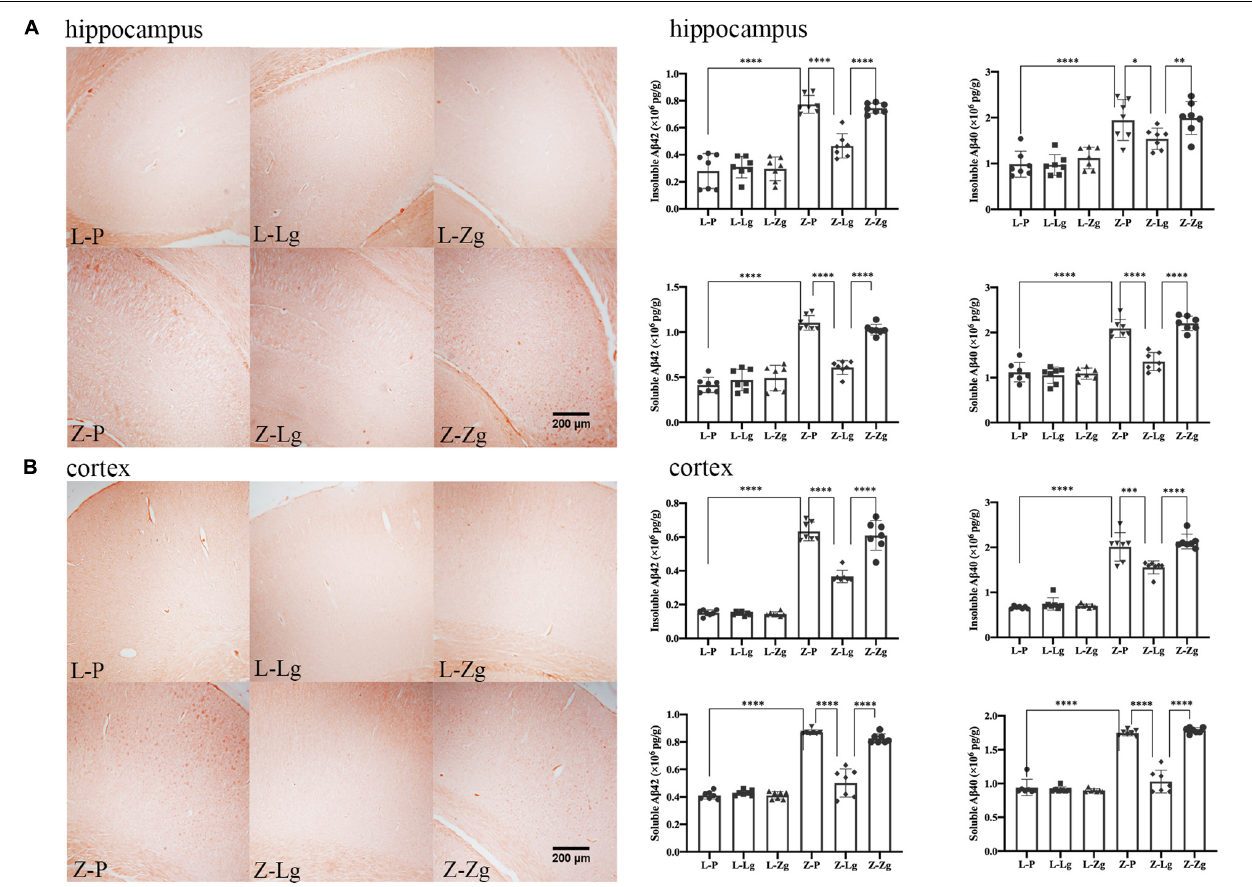
FIGURE 5 | GMT changes A β plaque burden in ZDF recipient rats. (A) Representative photographs of Congo red staining (Magnification 40 × ) and levels of insoluble and soluble A β 42 and A β 40 in the hippocampus regions [insoluble A β 42: F ( 5 , 36 ) = 48.60, P < 0.0001; insoluble A β 40: F ( 5 , 36 ) = 16.32, P < 0.0001; soluble A β 42: F ( 5 , 36 ) = 66.70, P < 0.0001; soluble A β 40: F ( 5 , 36 ) = 58.05, P < 0.0001]. (B) Representative photographs of Congo red staining (Magnification 40 × ) and levels of insoluble and soluble A β 42 and A β 40 in the cortex regions [insoluble A β 42: F ( 5 , 36 ) = 177.5, P < 0.0001; insoluble A β 40: F ( 5 , 36 ) = 116.2, P < 0.0001; soluble A β 42: F ( 5 , 36 ) = 132.6, P < 0.0001; soluble A β 40: F ( 5 , 36 ) = 159.9, P < 0.0001]. Data are shown as mean ± SD ( n = 3–7 per group). ∗ P < 0.05, ∗∗ P < 0.01, ∗∗∗ P < 0.001, ∗∗∗∗ P < 0.0001. One-way or two-way ANOVA, followed by Tukey’s post-hoc